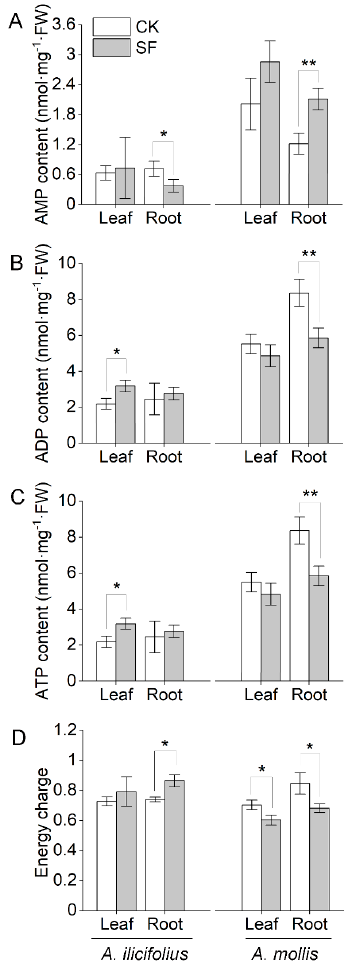
Figure 7. Effects of tidal flooding stress on ( A ) adenosine monophosphate content, ( B ) adenosine diphosphate content, ( C ) adenosine triphosphate content, and ( D ) energy charge of A. ilicifolius and A. mollis. * and ** indicate significant difference at the 0.05 level and the 0.01 level, respectively. CK and SF represent the control group and soil tidal flooding stress, respectively.